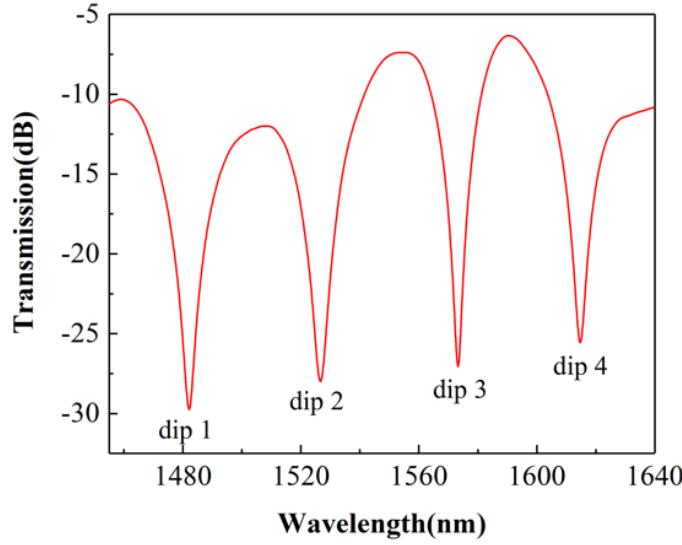
Figure 7. Spectrum of the SCSHF sensor.